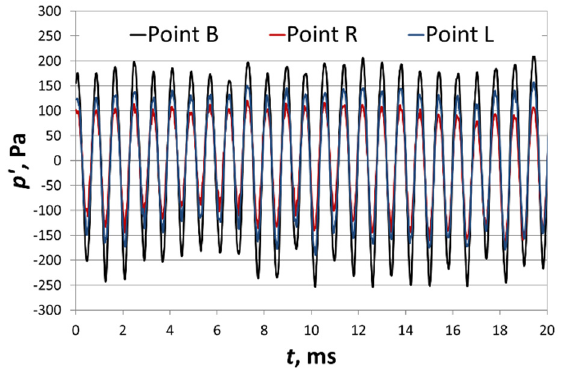
Figure 12. Acoustic pressure fluctuations for velocity in the main channel equal to 50 m/s—experimental data.